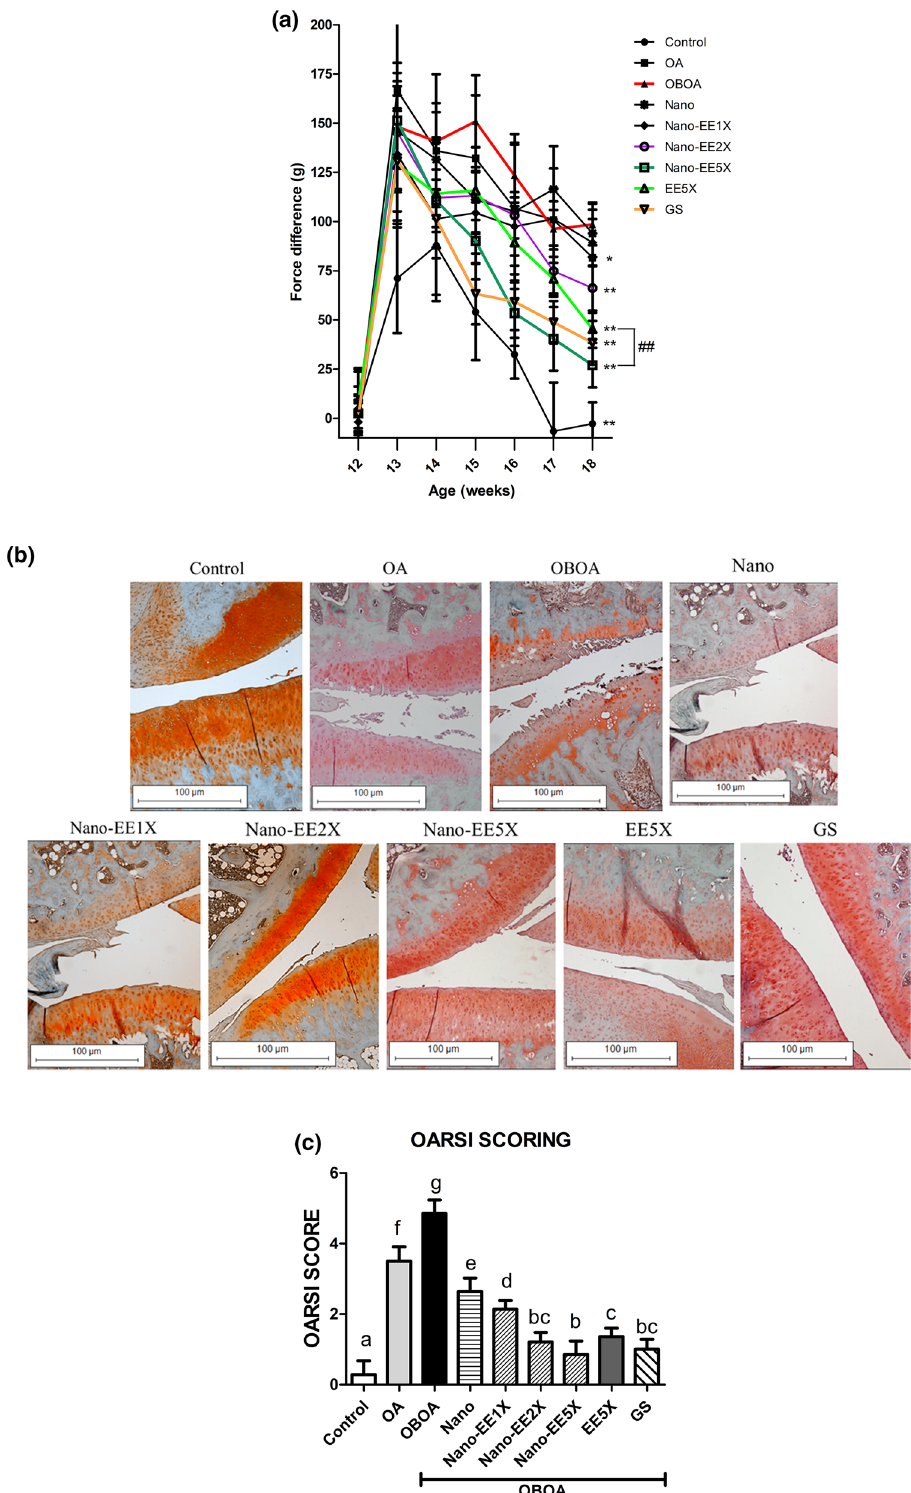
Figure 7. ( a ) Incapacitance test in osteoarthritis rats fed different doses of Nano-EE and EE after 6 weeks. Data are shown as the mean (n = 6 rats/group). p < 0.05 (*), p < 0.01 (**) vs. OBOA. p < 0.05 (#), p < 0.01 (##) represent significantly different between EE5X and Nano-EE5X. ( b ) Histology staining (Safranin O) of OA rats after different doses of Nano-EE and EE after 6 weeks. The scale bar length is 500 µm. The knee joints of rats with OA were stained with Fast Green/Safranin-O. ( c ) OARSI score of cartilage tissues. Grade 0: surface intact, cartilage morphology intact, grade 1: surface intact, grade 2: surface discontinuity, grade 3: vertical fissures (clefts), grade 4: erosion, grade 5: denudation, grade 6: